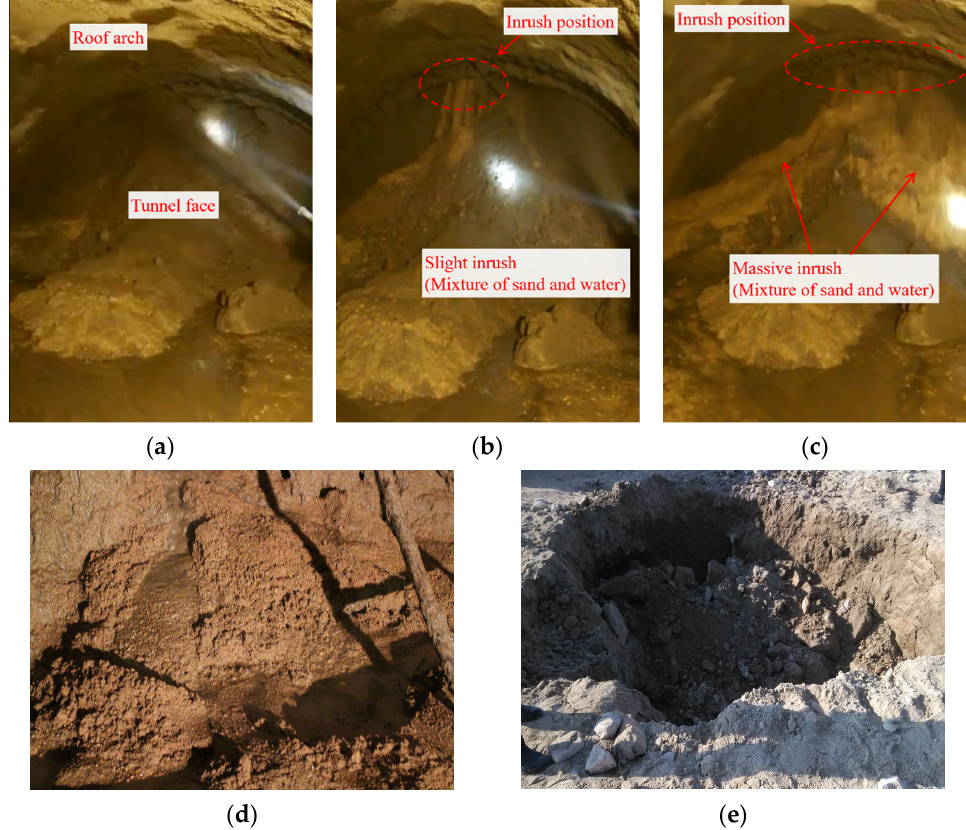
Figure 9. Process of inrush of sand and water. ( a ) Excavation instant. ( b ) Early stage. ( c ) Late stage. ( d ) Mixture of sand and water. ( e ) Ground surface subsidence.